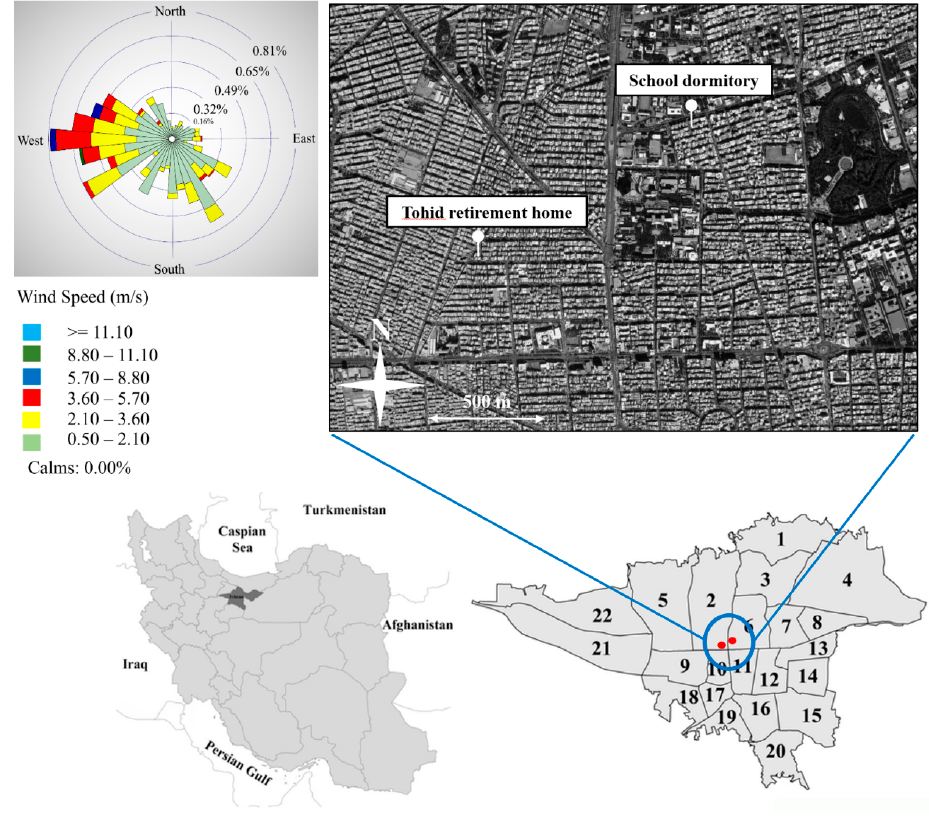
Figure 1. Location of the sampling sites and the average wind rose during the sampling period.